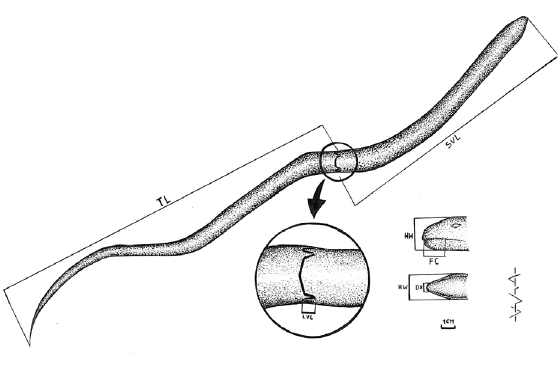
Figure 1. Relation of the morphometric variables measured in Ophiodes striatus belonging to the Coleção Herpetológica da Universidade Federal de Juiz de Fora - Reptiles